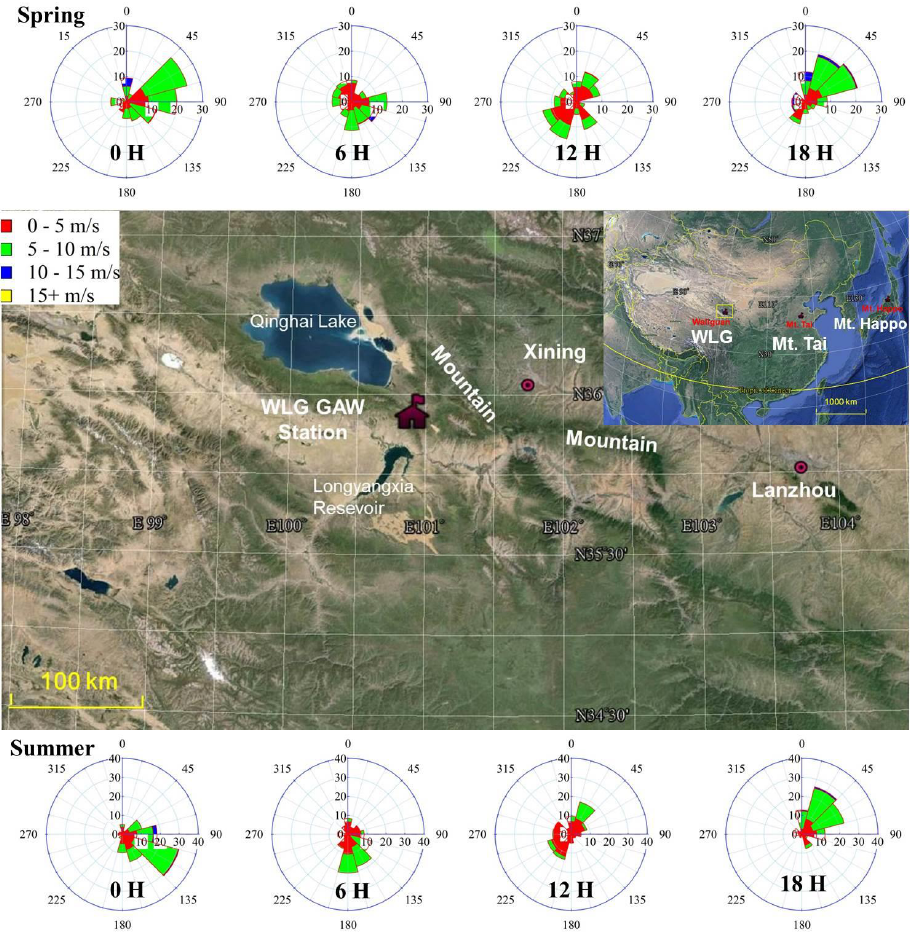
Figure 1 Fig. 1. Map from Google Earth showing the WLG Observatory and surrounding areas. The main figure is the zoomed view of the yellow box in the inner map. The diurnal variations of surface wind recorded in spring and summer are also